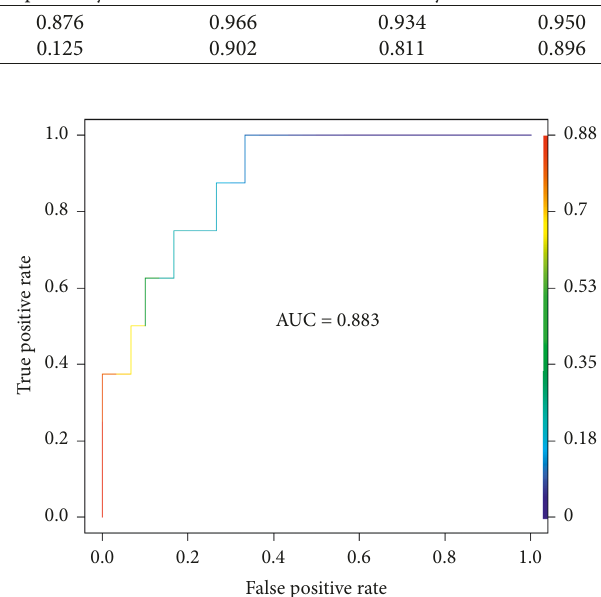
Figure 3: ROC curve based on the RF prediction model.